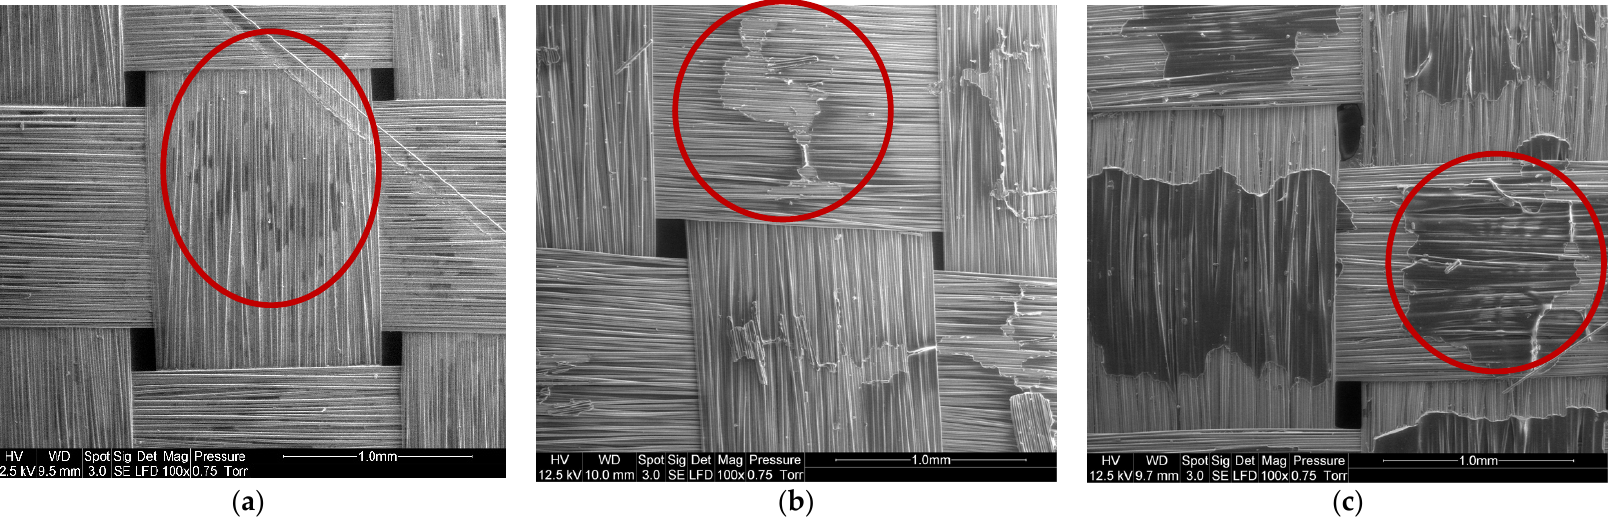
Figure 10. SEM image of ( a ) Basalt fibers recovered by mechanical stirring (1:40 ratio) during 7 h, ( b ) Basalt fibers recovered with ultrasound at the beginning of the dissolution (1:4 ratio) during 16 h and ( c ) Basalt fibers recovered with ultrasound at the end of the dissolution (1:4 ratio) during 7 h.